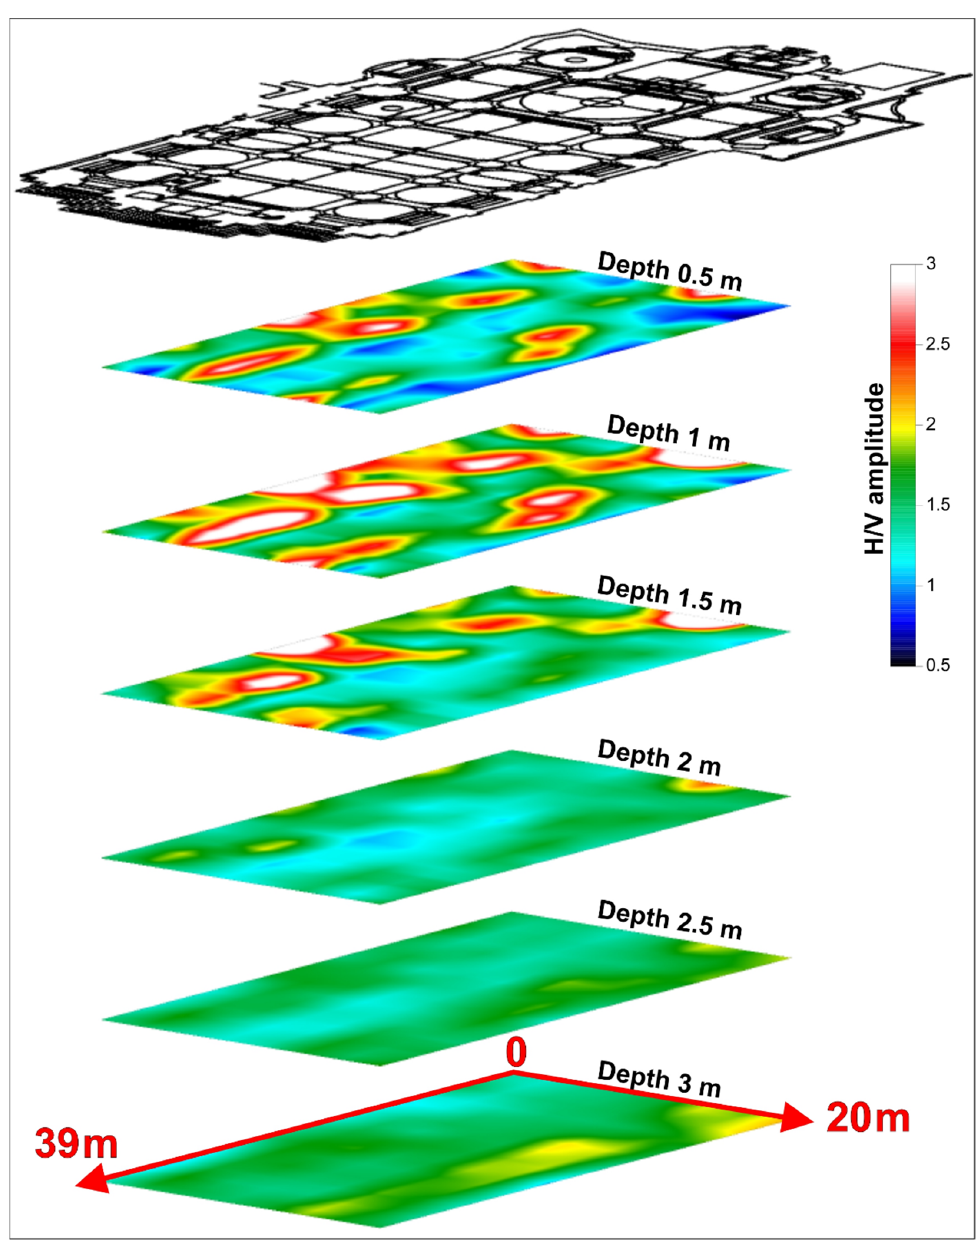
Figure 11. Depth slices showing the variation of the H/V spectral ratio amplitude with the depth.